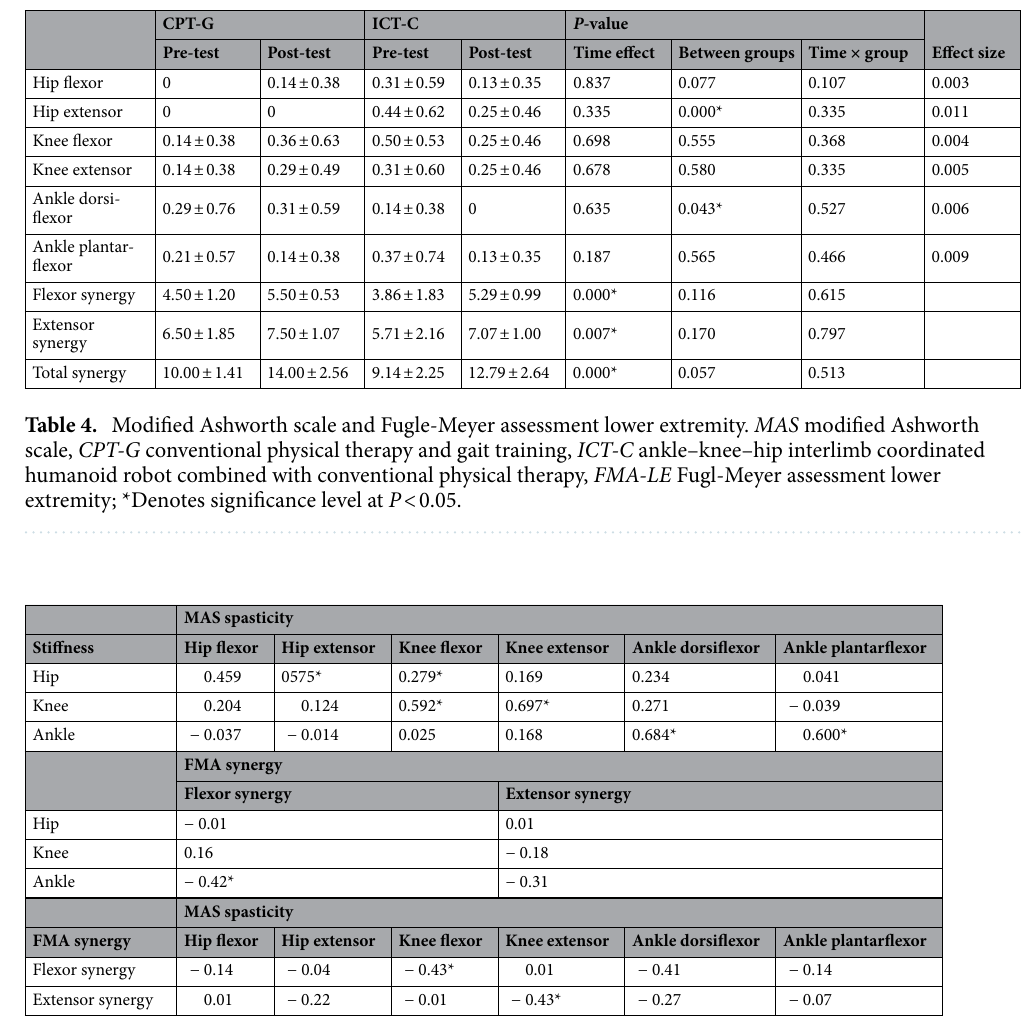
(Table 4). ANOVA failed to yield a significant difference in the FMA-LE synergy scale score between CPT-G and ICT-C ( P = 0.12, 0.17; Table 4).